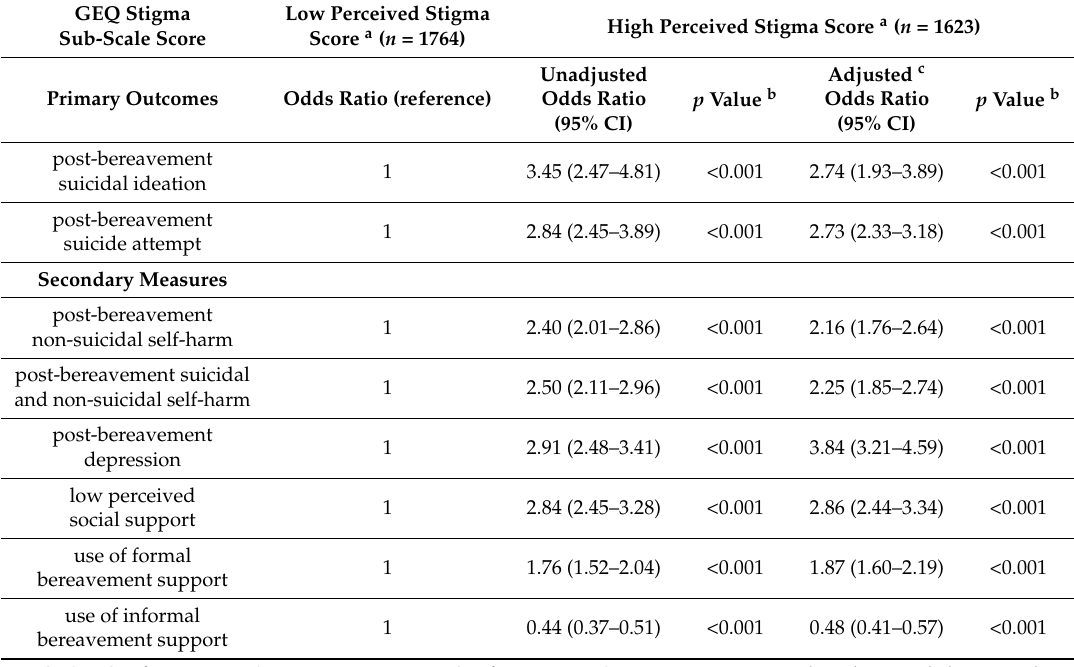
Table 3. Estimates of the association between high stigma scores and